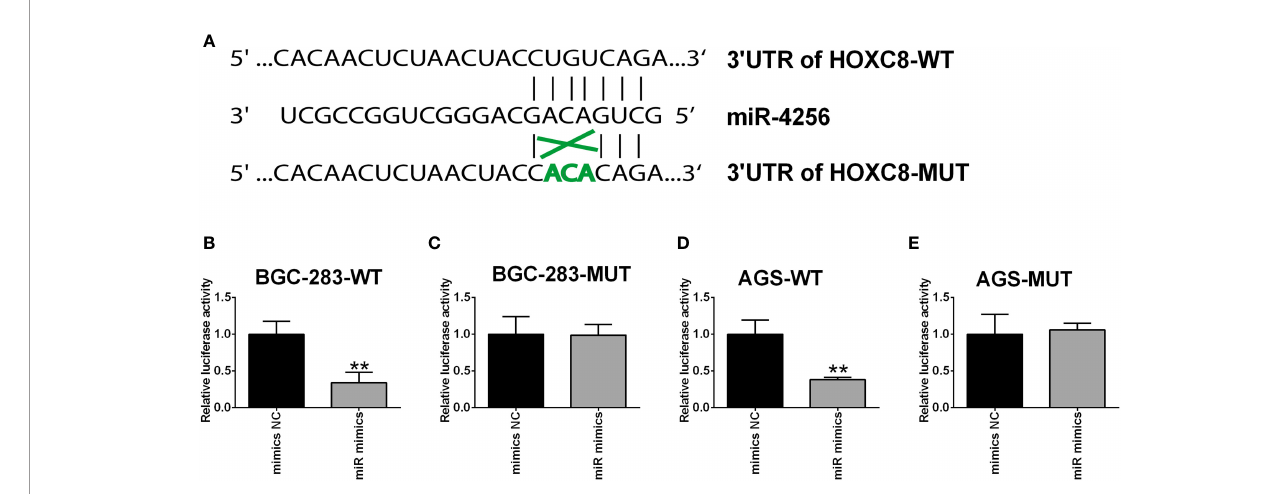
FIGURE 10 | HOXC8 was a direct target of miR-4256. (A) The predicted binding sites between miR-4256 and HOXC8 3 ’ UTR. (B, C) The relative luciferase activity in BGC-283 cells co-transfected with miR-4256 mimics (or mimics NC) and wide type (B) or mutant (C) 3 ’ UTR of HOXC8. (D, E) The relative luciferase activity in AGS cells co-transfected with miR-4256 mimics (or mimics NC) and wide type (D) or mutant (E) 3 ’ UTR of HOXC8.